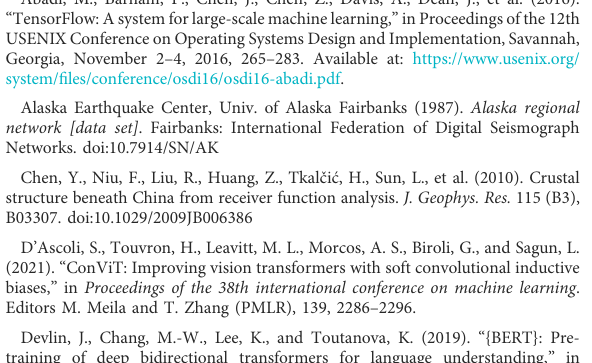
station AK.SAW dataset by the CNN-BiLSTM model with earthquake magnitudes between 5.0 and 5.5. (C,D) are the same as (A,B) but for station IC.QIZ datasets. (E,F) are the same as (A,B) but for station CB.CAD datasets. SUPPLEMENTARY FIGURE S10 Training and validation loss of the CNN-BiLSTM model used training set labeledbythetraditionalmethod(HiPerSeis). (A) StationAK.SAWdataset. (B) station IC.QIZ dataset. (C) Station CB.CAD dataset. SUPPLEMENTARY FIGURE S11 Training and validation loss of the CNN-BiLSTM model used manually labeled training set from all the three stations (AK.SAW, IC.QIZ, and CB.CAD). SUPPLEMENTARY FIGURE S12 Training and validation loss of the CNN-BiLSTM model used manually labeled training set from two stations. (A) Using training set from station IC.QIZ and station CB.CAD. (B) Using training set from station AK.SAW and station CB.CAD. (C) Using training set from station IC.QIZ and station CB.CAD. SUPPLEMENTARY TABLE S2 Normalized confusion matrixes of the traditional method with different distance thresholds on station AK.SAW dataset (magnitude >